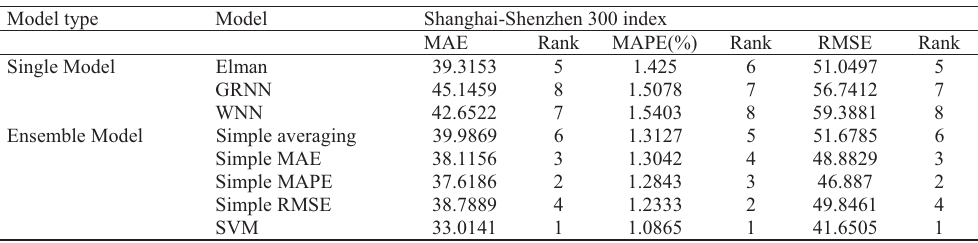
Table 4. Comparison of performance statistics averaging each model over 20 runs in Shanghai-Shenzhen 300